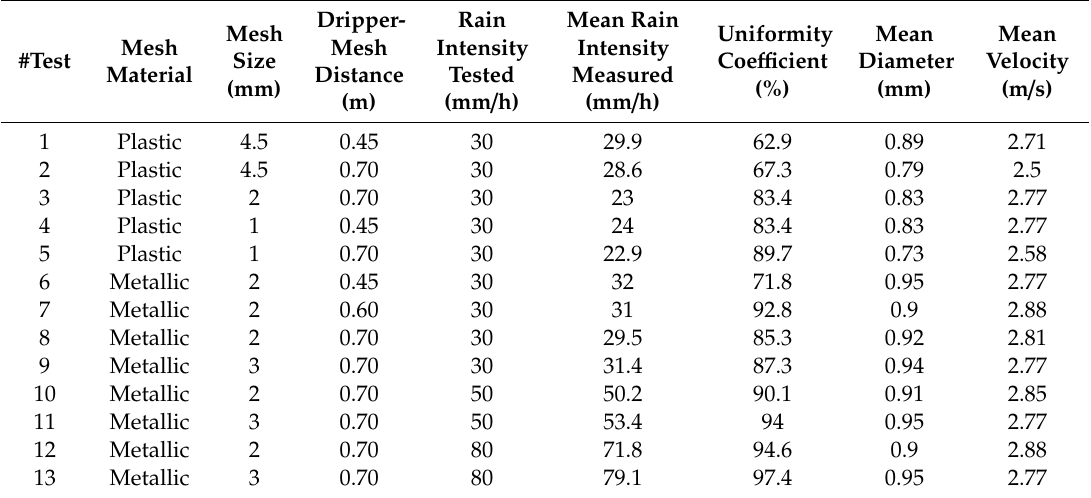
Table 2. Configurations and results of the tests performed during the rainfall simulator calibration.